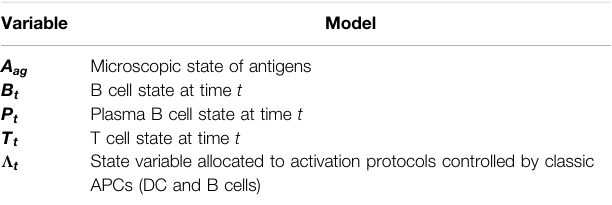
TABLE 1 | Lymphocytes, pathogens (antigens) and different APC agents in the MMQE.